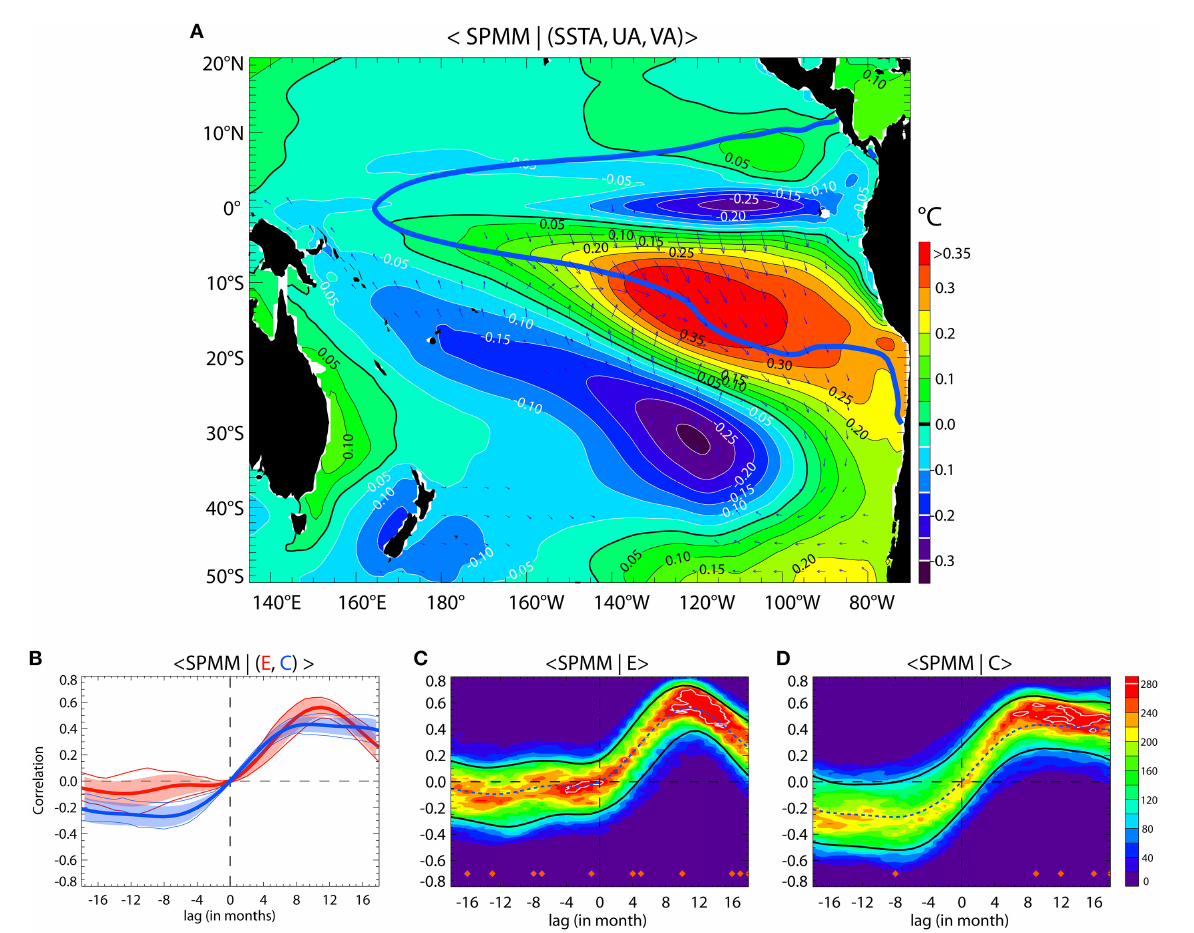
FIGURE3 (A) Regression map of the SVD leading mode SST/Wind expansion coefficients for the SST and 10-m wind vectors. The expansion coefficients have been normalized so that units are ◦ C and m/s for SST and wind respectively. The longest arrow on the maps corresponds to a wind amplitude of 0.89 m/s. The covariance of the mode is 83 3.4%. The contour in thick blue line corresponds to the iso-contour 0.25 ◦ C of the E ± mode pattern. (B) Ensemble mean lagged correlation between the SPMM index and (red) E and (blue) C indices. The shading in corresponding color indicates the standard deviation amongst the ensemble, while the thin lines indicate the 10% and 90% percentiles. Negative lag means ± SPMM ahead E/C. (C, D) Distribution of the correlation between the SPMM index and the (C) E and (D) C indices as a function of lead time for 20-year periods chunks of the historical runs of the CESM model. The black lines indicate the 10 and 90% percentiles. The dashed line in blue corresponds to the ensemble mean of the lagged correlation [i.e., curves of (B) ]. The red diamonds indicate where the “dip test” for multimodality yields a p value lower than 0.05 (i.e., passing the 95%